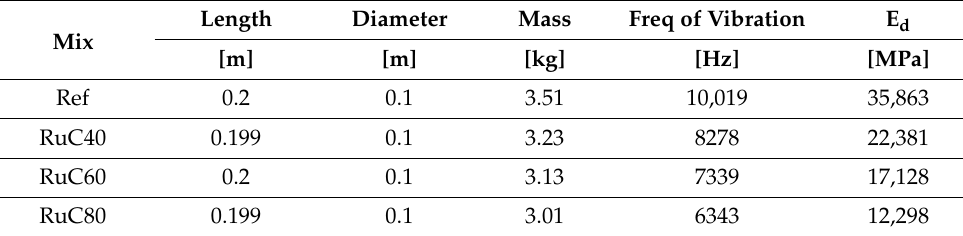
Table 2. Dynamic modulus.